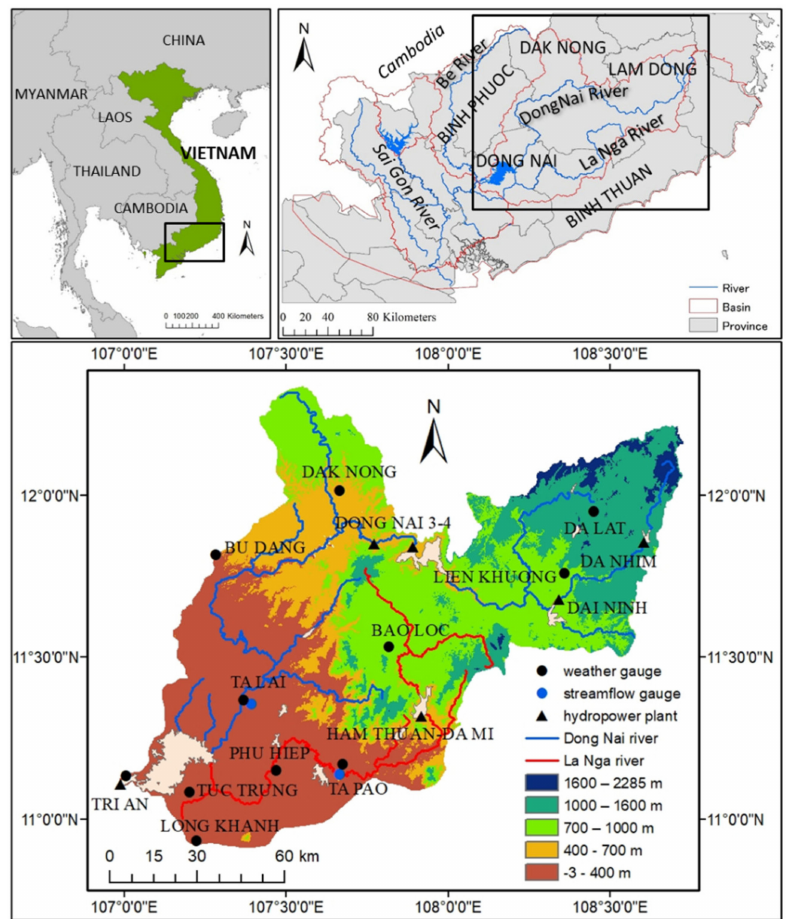
Figure 1. The UDNB with weather, stream gauges and hydropower-plant locations. (Modified from